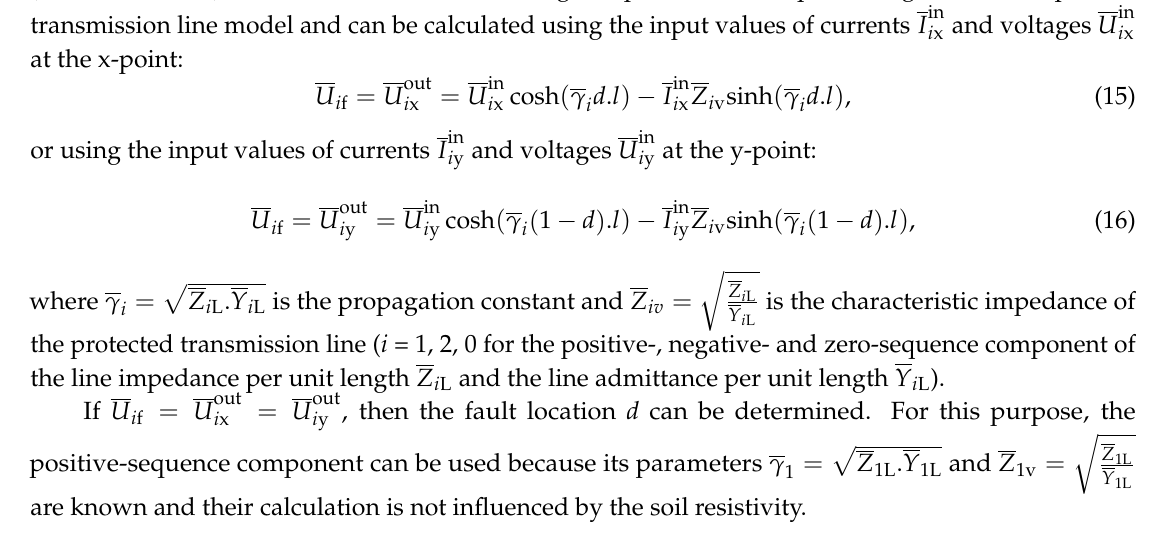
Figure 4 . An equivalent circuit for a single-phase fault. To calculate the fault location, individual sequence component voltages at the fault point (where i = 1, 2, 0) are determined. These voltages represent the output voltages of the respective transmission line model and can be calculated using the input values of currents